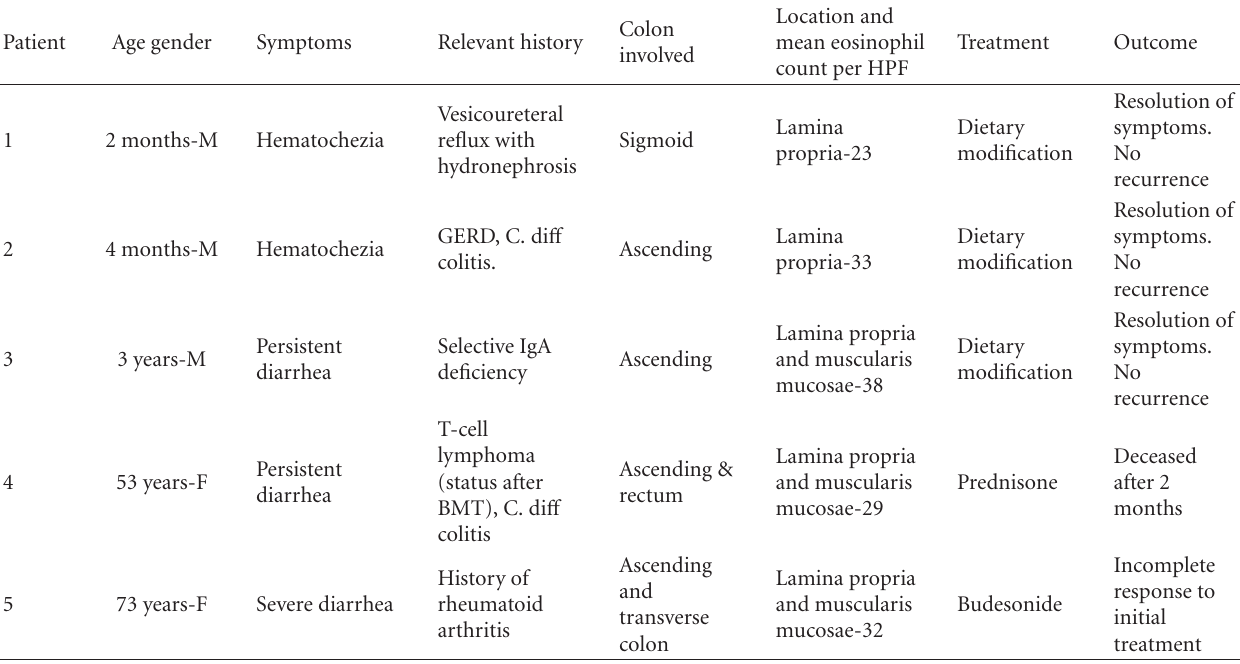
Table 1: Case series of four patients with eosinophilic